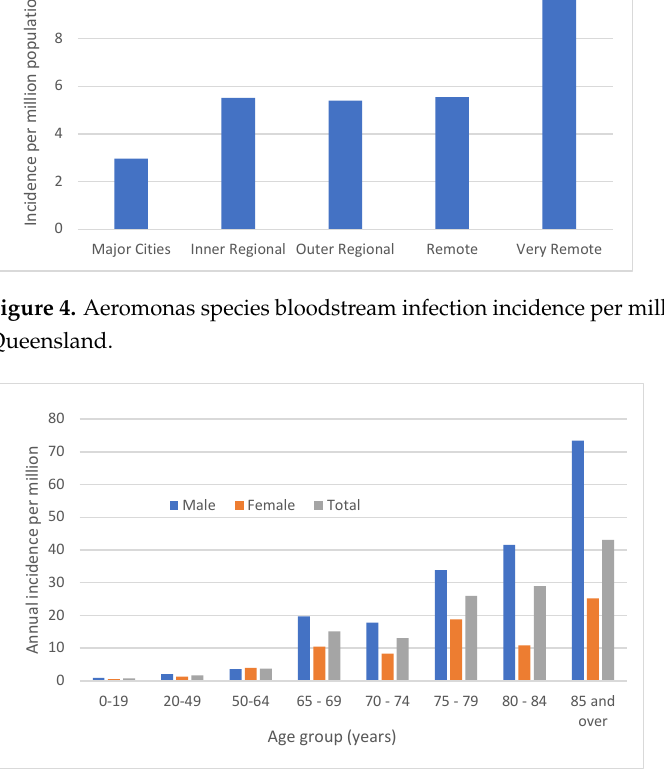
Figure 5. Incidence of Aeromonas species bloodstream infection by age and sex, Queensland, 2000–2019. 3.3. Patient Characteristics, Source of Bloodstream Infection, Polymicrobial Infection, and Antimicrobial Susceptibilities